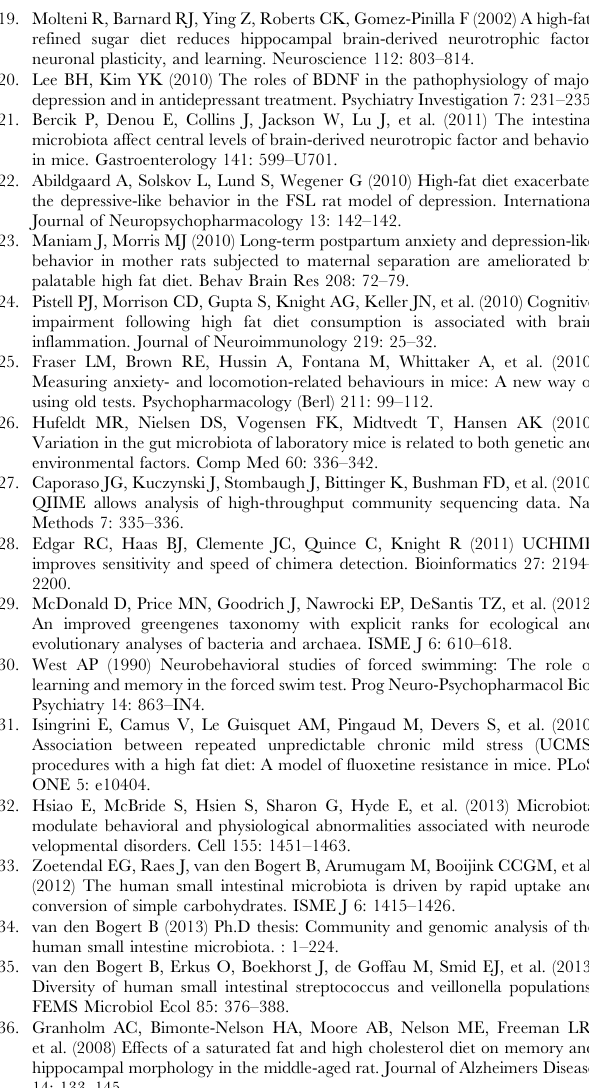
Figure S1 Dendrogram of the cluster analysis based on fecal DGGE fingerprints of week 10. The boxes on the right show the clustering at 74% similarity level (blue line). As it is seen, seven mice on high-fat diet show strong similarity in their GM, despite being housed individually. Some clustering is also seen for the two other groups, visualized by colored boxes containing animals from only one diet group. A: f =high-fat diet, c = control diet, s= high- sugar diet. B: The DGGE-gel the sample was run on. C: Mouse number. Figure S2 Boxplot showing the difference in fecal microbial composition at week 10 of the diet trial. The second